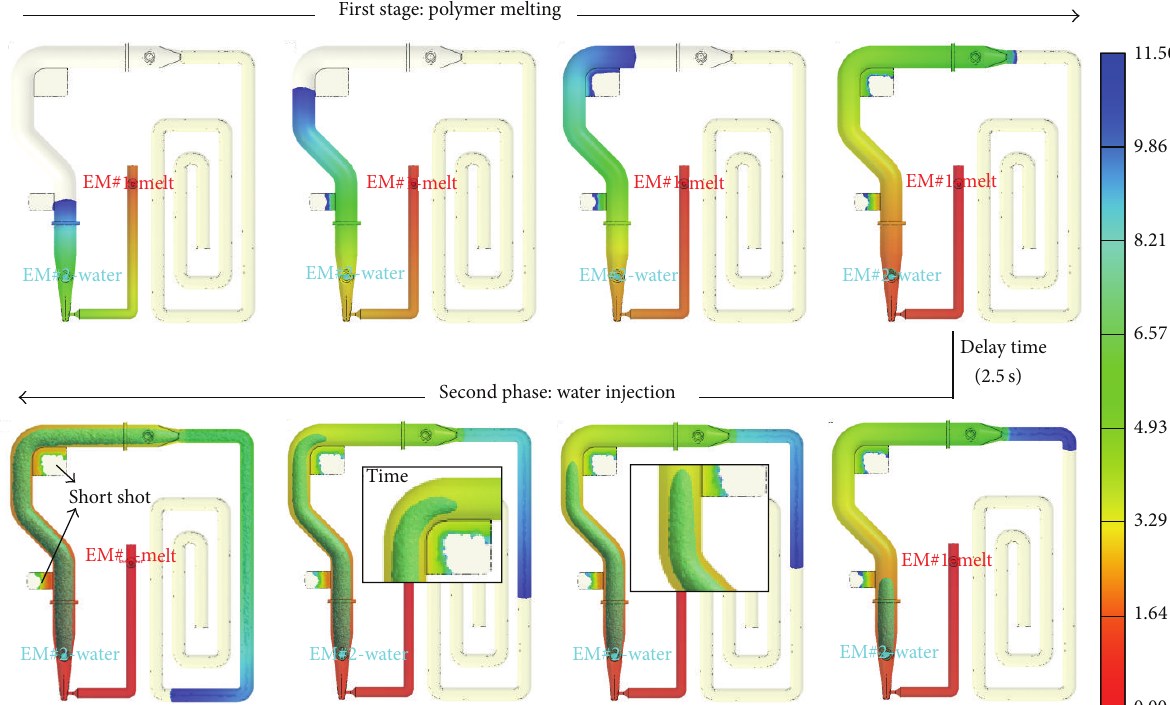
Figure 2: Filling patterns for WAIM in CAE